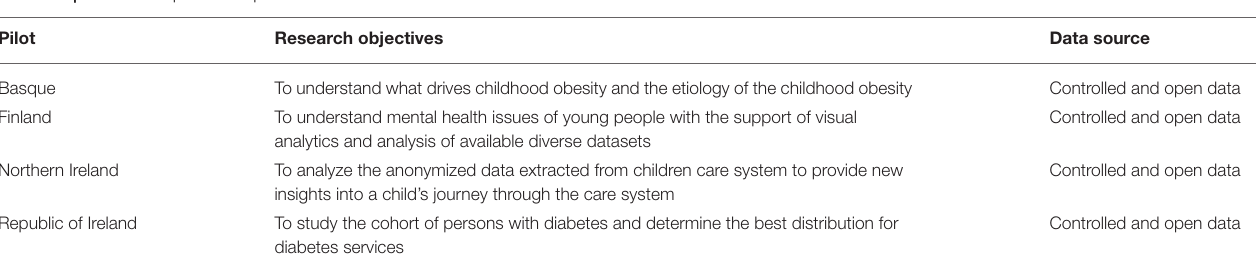
TABLE 1 | Research topics for all